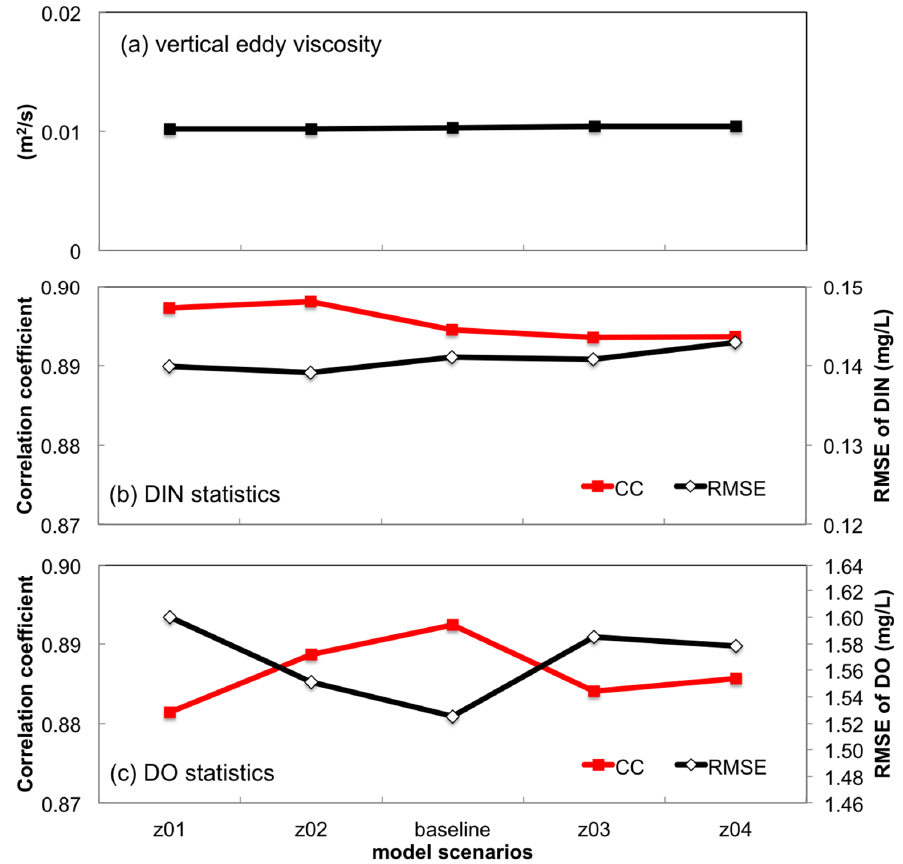
Figure 11. ( a ) The average eddy viscosity; CC and RMSE of ( b ) dissolved inorganic nitrogen and ( c ) dissolved oxygen in 2010 in five scenarios of varying bottom roughness length scale (z01, z02, baseline, z03 and z04 in Table 2). CC and RMSE denote the correlation coefficient and root mean squared error between the model simulation and the observation, respectively.